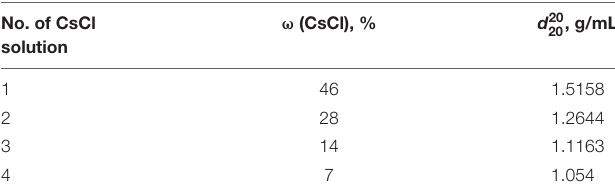
TABLE 1 | CsCl solutions used in the gradient column (in order of